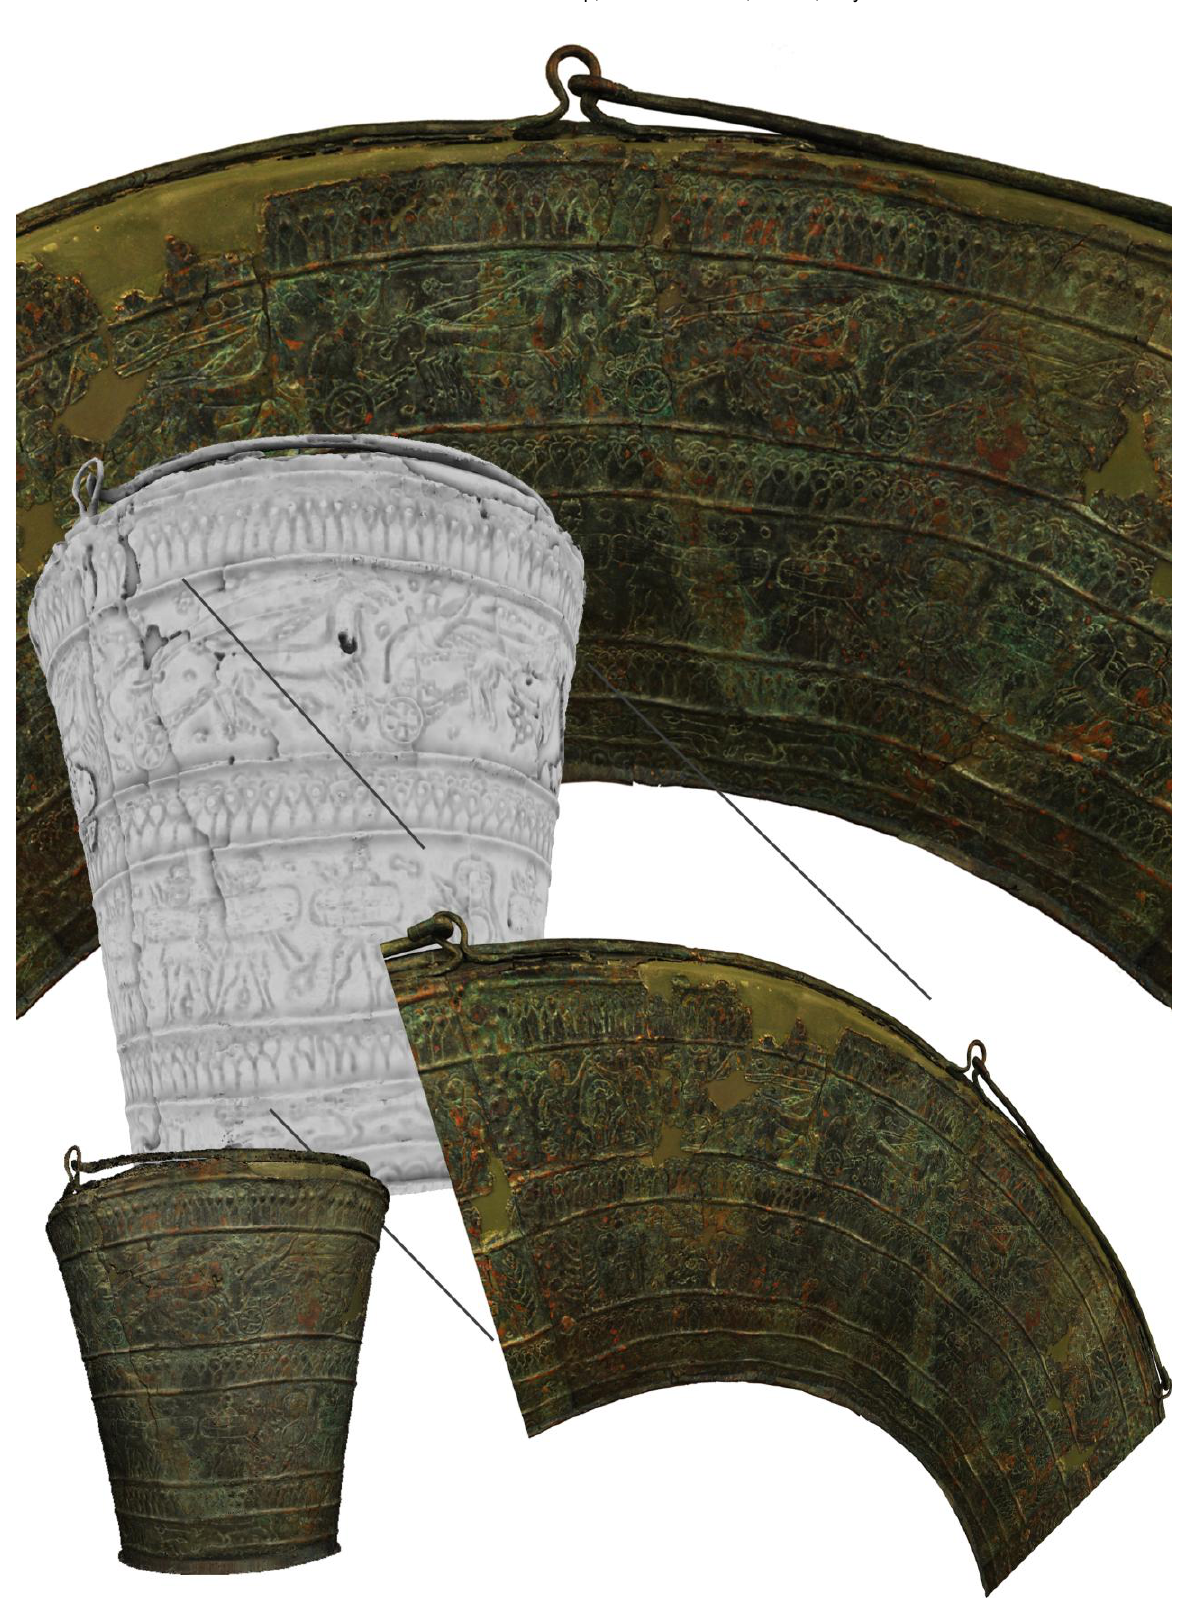
Figure 5. Unfold of the texture of the 3d model of situla Arnoaldi. Top, detail of the bronze lamina projection on a flat surface. The narration is represented through engravings and figures stacked in three superimposed registers, representing different life scenes and mores. Centre, shallow engravings have been highlighted using graphic procedures that ease to recognition of figures and scenes that are not evident because of the dark and pied colour of